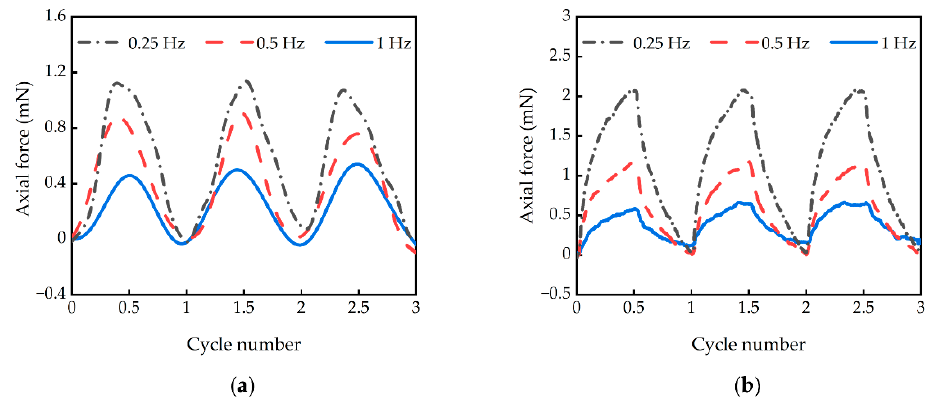
Figure 9. Axial forces of the helical IPMC actuator under different signals with different frequencies: ( a ) sinusoidal signal; ( b ) square wave signal.